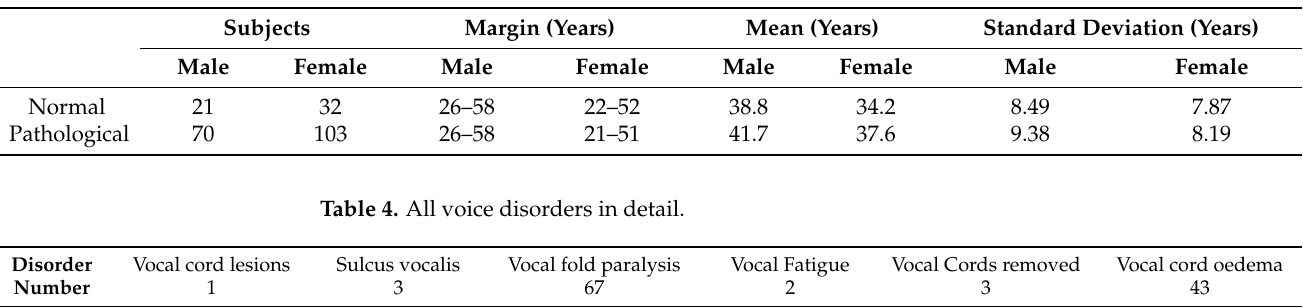
Table 3. Gender and age distribution of the recordings in the chosen subset of MEEI database.